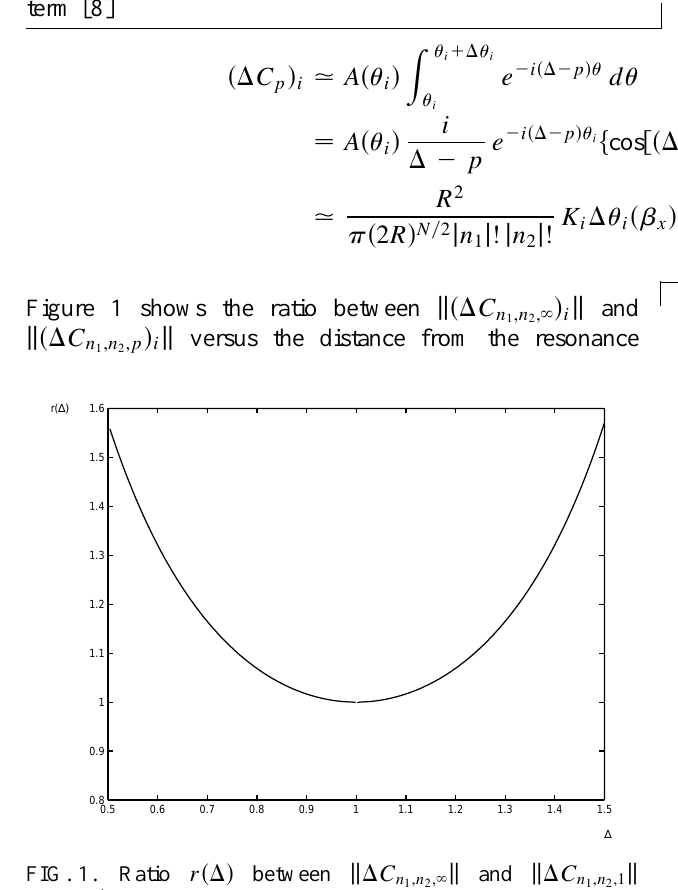
FIG. 1. Ratio r (cid:1) D (cid:2) between k D C n versus D